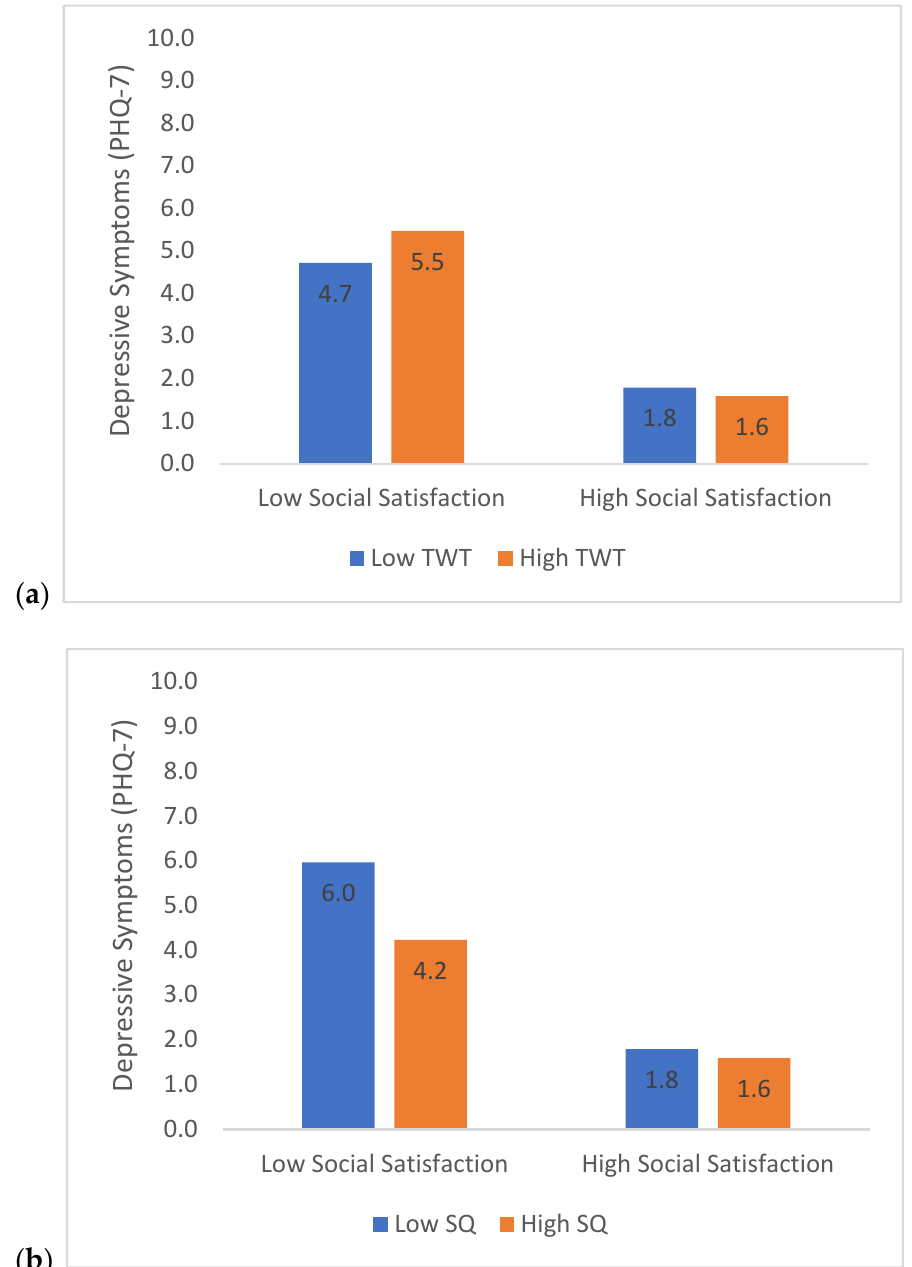
8 of 14 Figure 1. Estimated depressive symptoms (PHQ-7 scores) as a function of the association between social isolation and ( a ) total wake time (TWT), ( b ) sleep quality (SQ), and ( c ) physical activity (PA). High and low social isolation scores represent ± 2 SD from the sample mean ± 2 SD from the sample mean was also used to estimate high and low values for TWT, SQ, and PA.